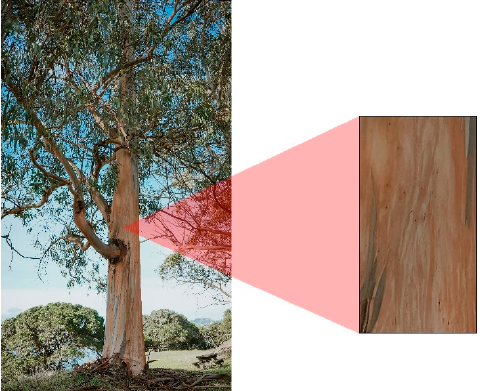
Figure 4. A tree trunk and tannins. Photo by Madeleine Maguire on Unsplash.